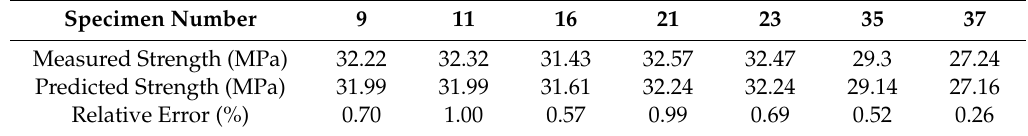
Table 3. Comparison of the experimental and DNN-predicted results of tensile strength for test